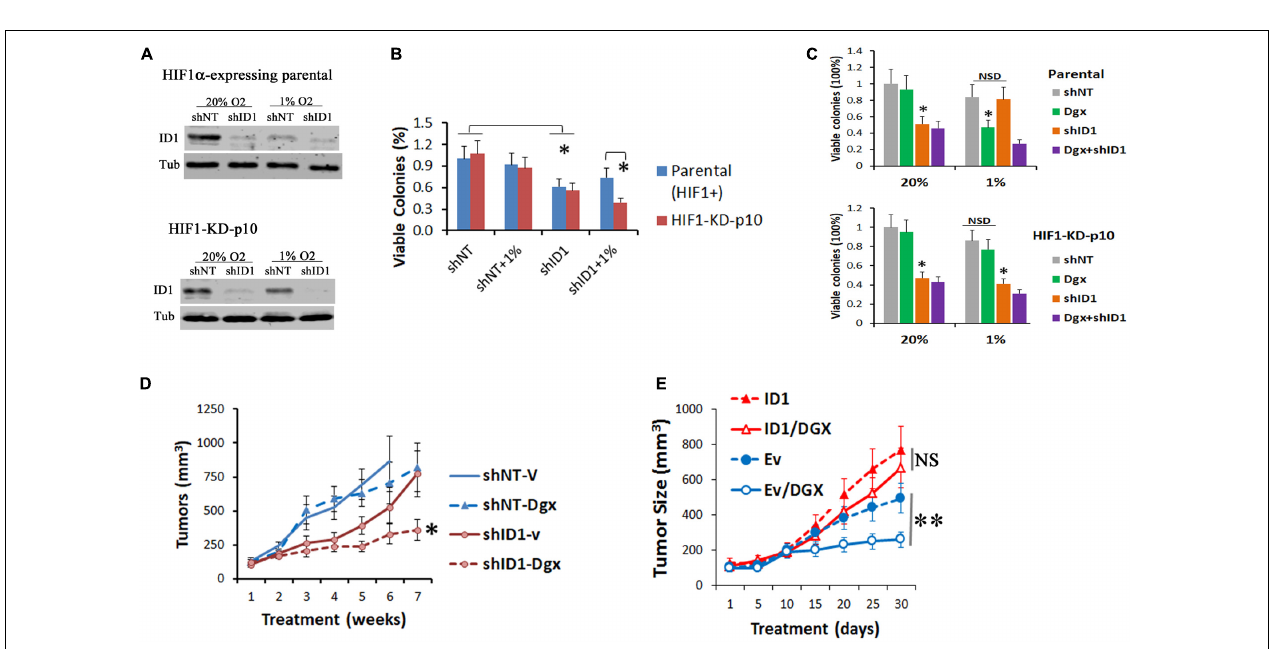
FIGURE 4 | (A) Hep3B-parental and -HIF1 α -KD-P10 cells were transduced with lentiviral shRNA-ID1. Cells were cultured in 20% or 1% O 2 for 24 h, and ID1 and tubulin proteins were determined by western blots. (B) Cells in (A) underwent colony formation assays in 20% or 1% O 2 , ∗ P < 0.05, t -test, mean and stdv, n = 3. (C) Parental-shNT/shID1 cells or HIF1 α -KD-P10-shNT/shID1 cells were treated with HIF inhibitor digoxin and underwent colony formation assays. ∗ P < 0.05, t -test, mean and stdv, n = 3. (D) HIF1 α -KD-P10-shNT/shID1 cells were injected into the flank of nude mice, and tumor-bearing mice were treated by vehicle or digoxin (Zhang et al., 2008). ∗ P < 0.05, ANOVA, mean and SEM, n = 6. (E) LNCaP-Ev/ID1 cells were injected into the flank of male nude mice, and tumor-bearing mice were treated by vehicle or digoxin. ∗∗ P < 0.05, t -test, mean and SEM, n = 6.